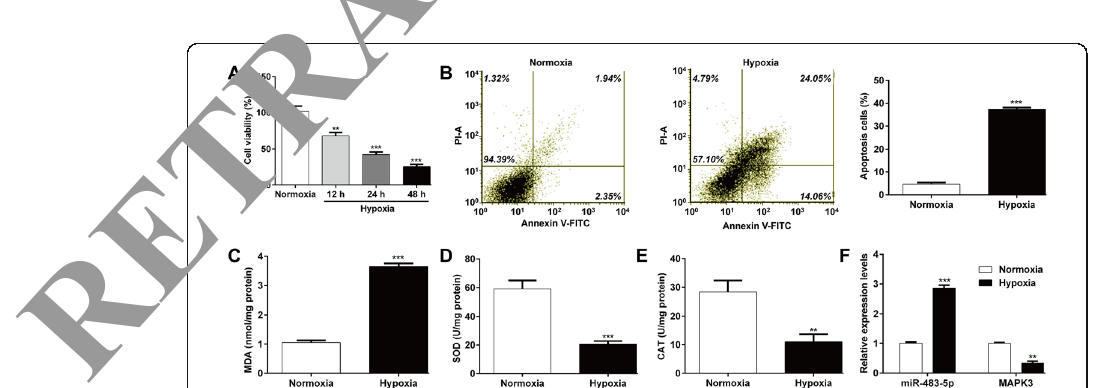
Fig. 2 Hypoxia induced cardiomyocyte damage and altered the expressions of miR-483-5p and MAPK3. a AC16 cells were maintained in a hypoxic incubator (94% N 2 , 5% CO 2 and 1% O 2 ) for 12, 24 and 48 h, followed by a CCK-8 assay, which showed decreasing cell viability. b through e After 24 h hypoxia treatment, AC16 cells underwent apoptosis analysis using flow cytometry and oxidative damage analysis for the content of MDA, and the activities of SOD and CAT using commercial assay kits. f The expression levels of miR-483-5p and MAPK3 were determined via quantitative real-time PCR in AC16 cells after 24 h under hypoxic conditions. Data are indicated as means ± SD of three independent experiments. ** p < 0.01, *** p < 0.001, as compared with